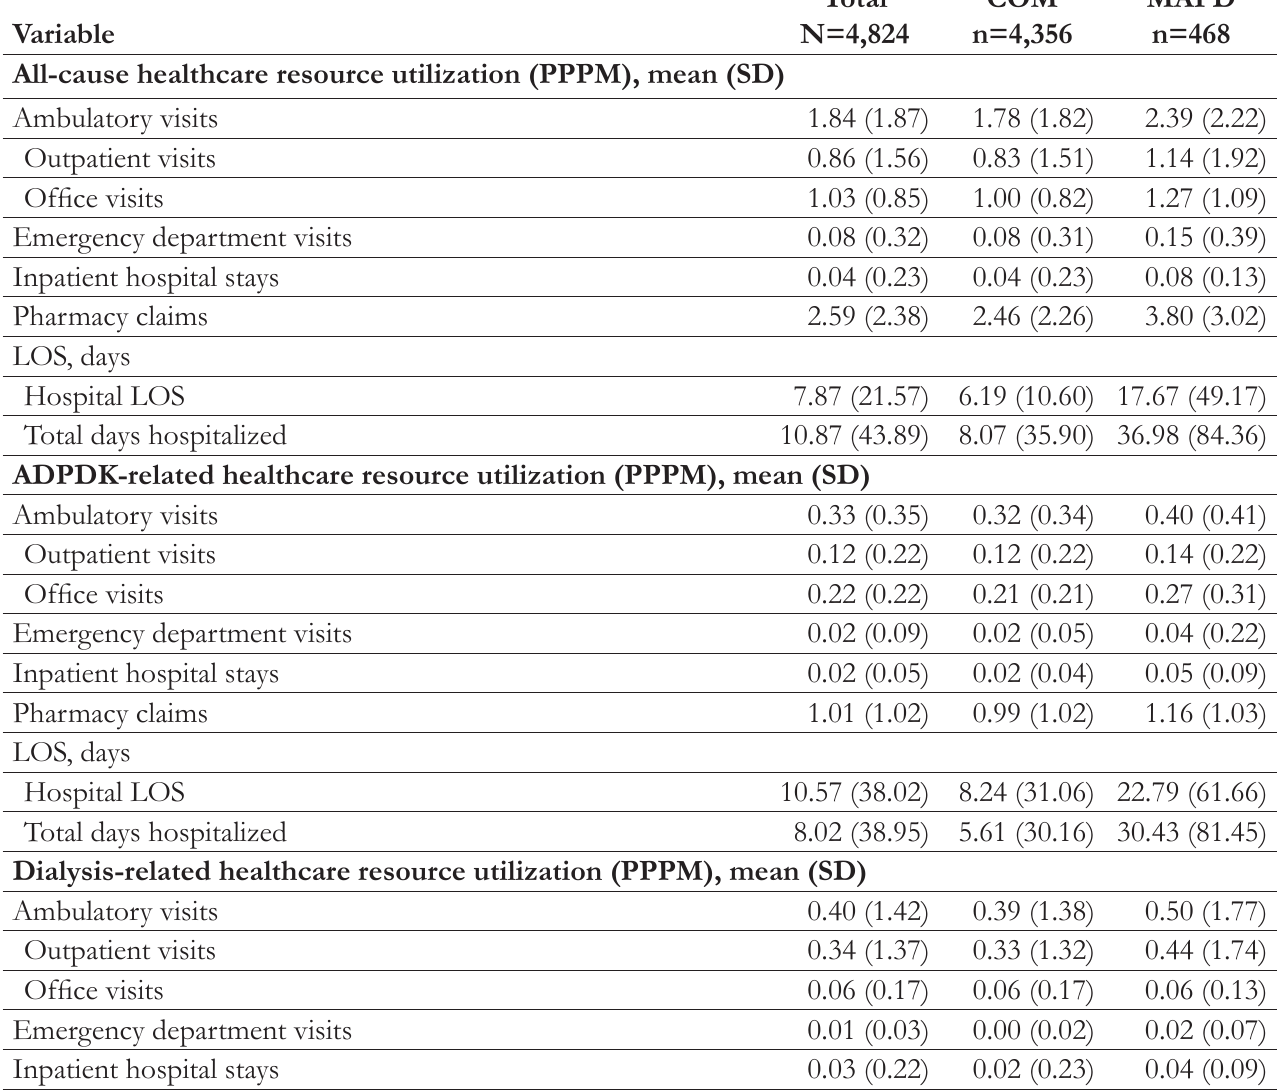
Table 2. Healthcare Resource